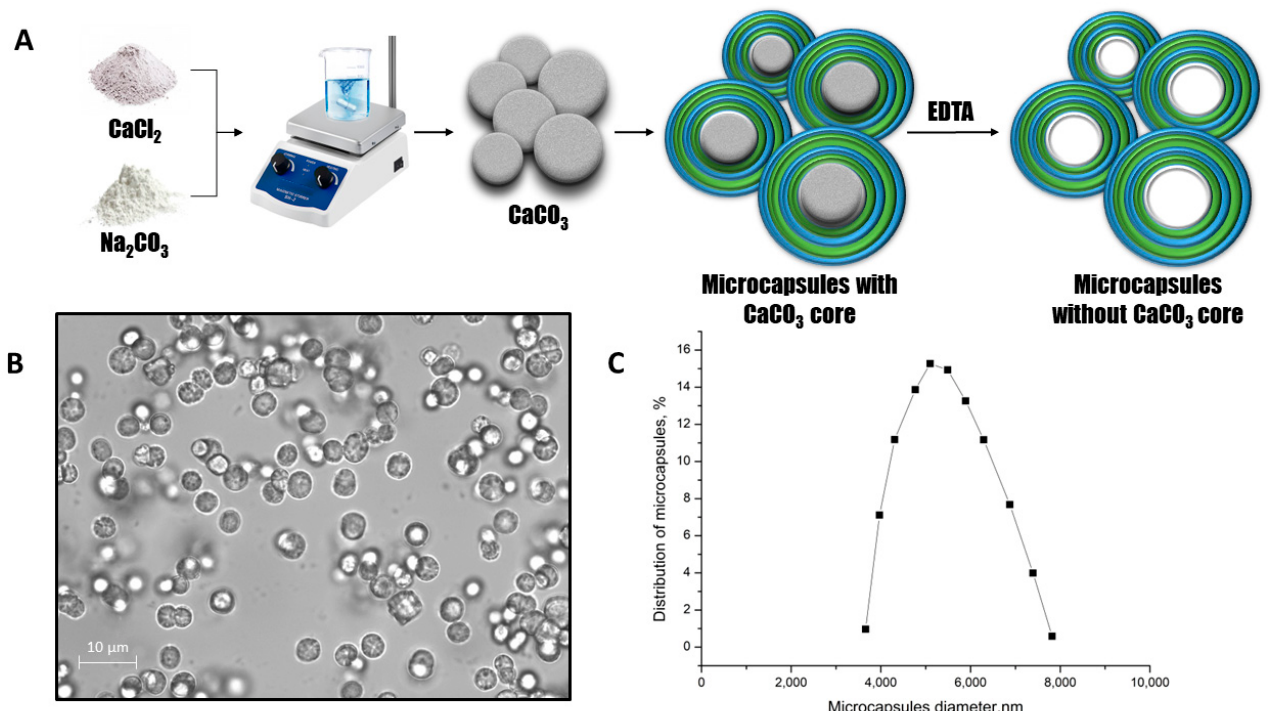
Figure 2. The scheme of the polyelectrolyte microcapsules preparation ( A ). The optical microscopy images of PMC ( B ). The PMC diameter distribution function ( C ).